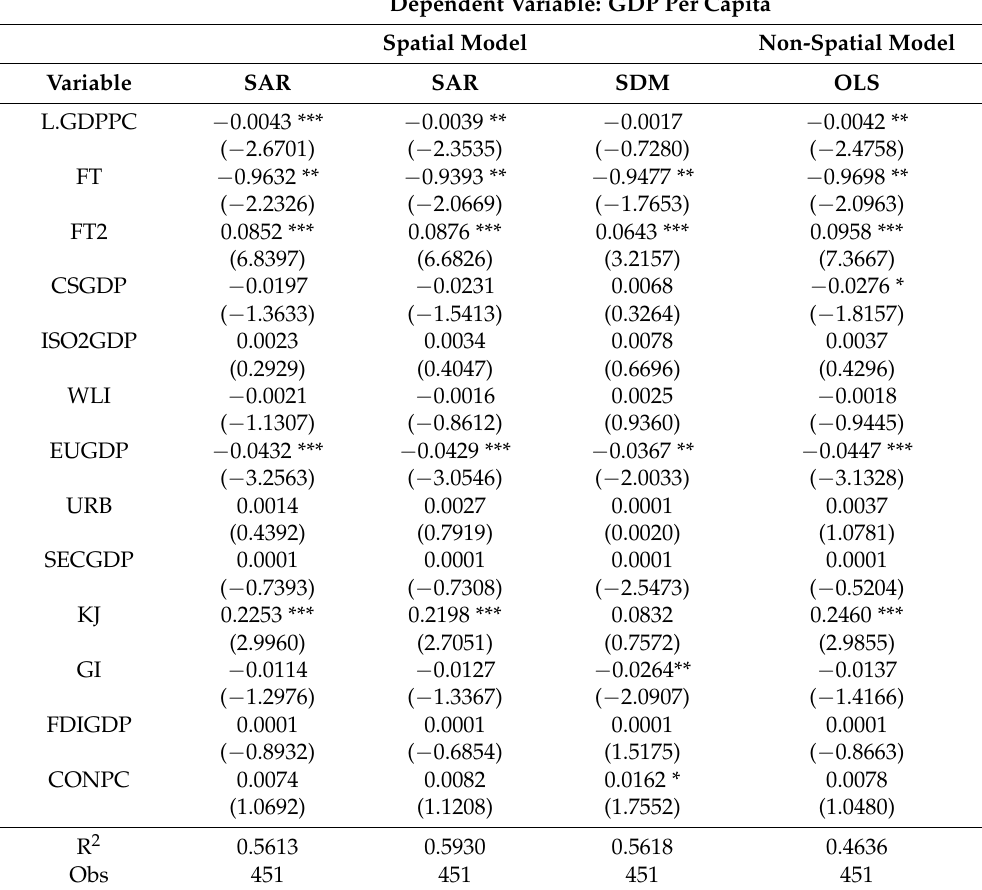
Table 8. Results of robustness checks from